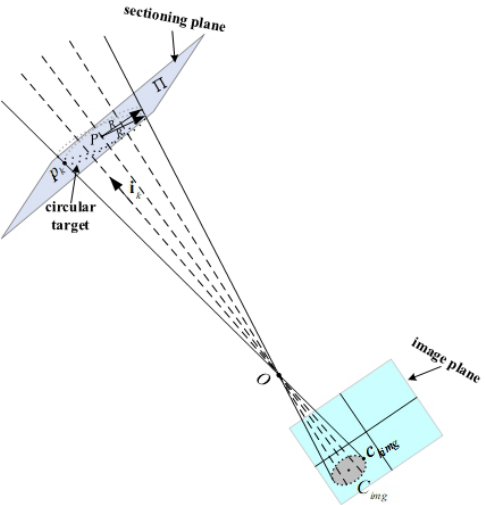
Figure 4. Parameter detection model for a space circular target. If any edge point of the image ellipse is assumed to be c kimg , then for each c kimg , the direction vector of the incident light i k